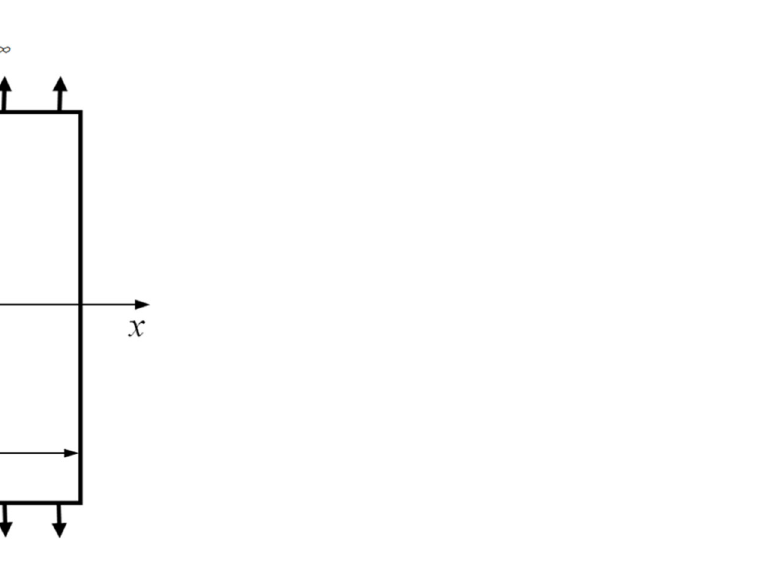
Figure 1. Coordinate system establishment and dimensioning of straight-notched laminated plate under tensile load, where W stands for the width of the specimen and the length of the straight notch is 2 C ; the direction of the tensile load is along the y ‐ axis.